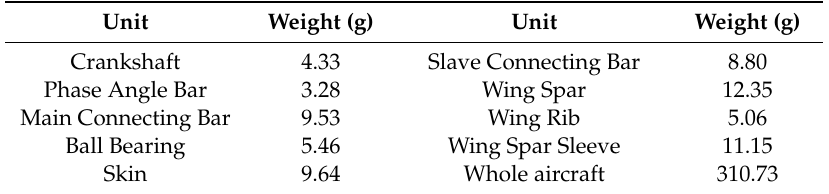
Figure 5. ( a ) The flapping wing model, ( b ) the flapping mechanism, and ( c ) the test model without skin. Table 1. Parts and mass of the experimental aircraft model.